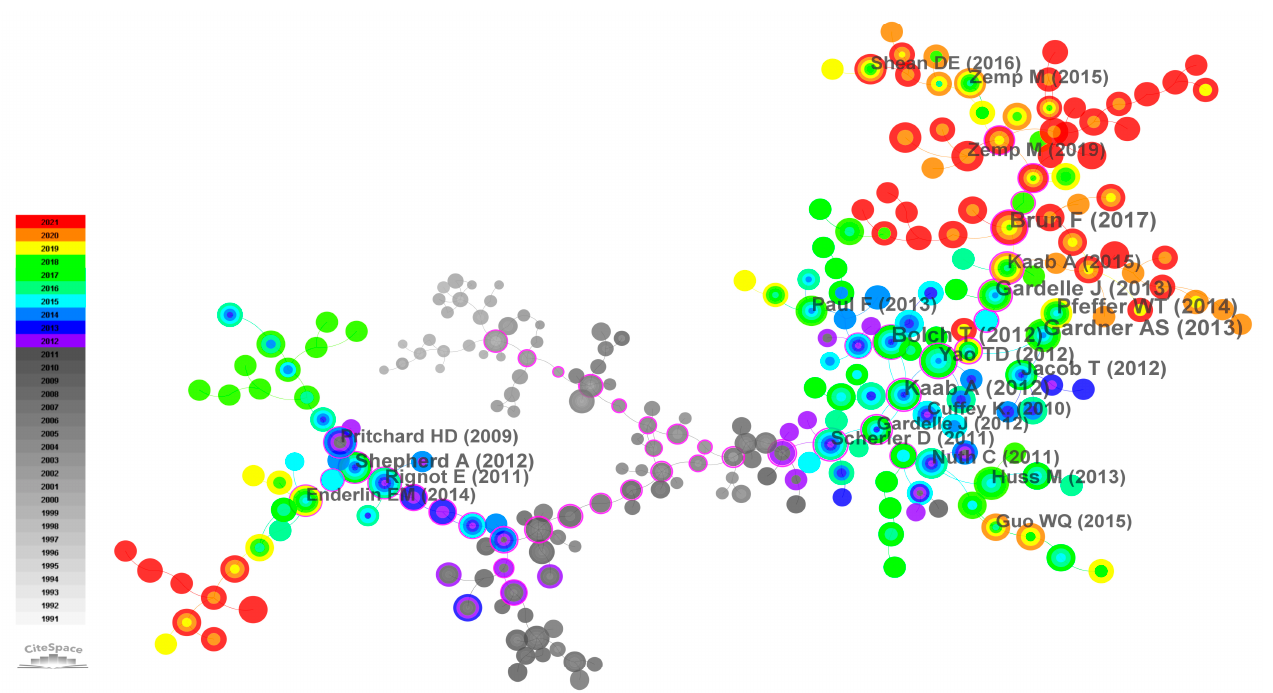
Figure 8. Knowledge map of co ‐ citation literature.